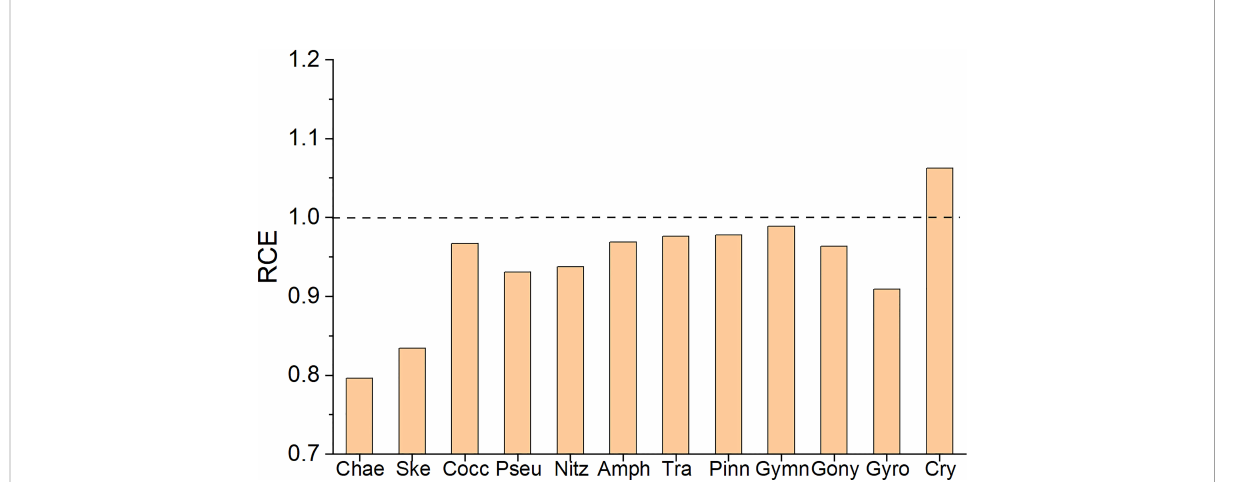
FIGURE 4 The ratio of clearance ef fi ciency (RCE) of dominant phytoplankton assemblages against total phytoplankton at Re fi ltration Index = 1. The following abbreviations were used for the different communities: Chae, Chaetoceros spp.; Ske, Skeletonema spp.; Cocc, Cocconeis spp.; Pseu, Pseudo-nitzschia spp.; Nitz, Nitzschia spp.; Amph, Amphora spp.; Tra, Trachyneis spp.; Pinn, Pinnularia spp.; Gymn, Gymnodinium spp.; Gony, Gonyaulax spp.; Gyro, Gyrodinium spp.; Cry,